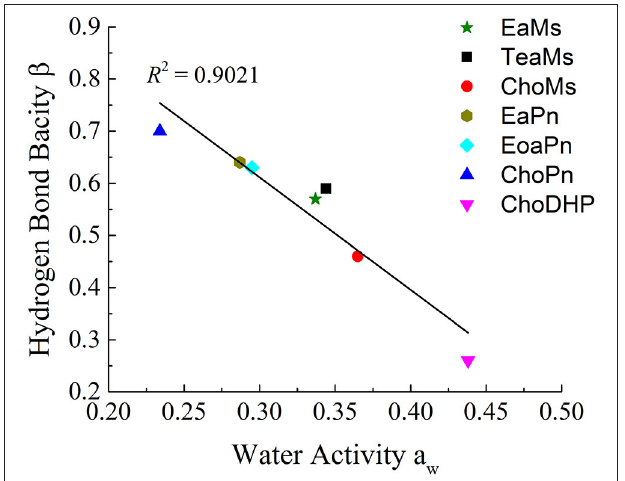
FIGURE 3 | The linear correlation between hydrogen bond bacisity β and water activity a w of hydrated ILs (25 mol%).